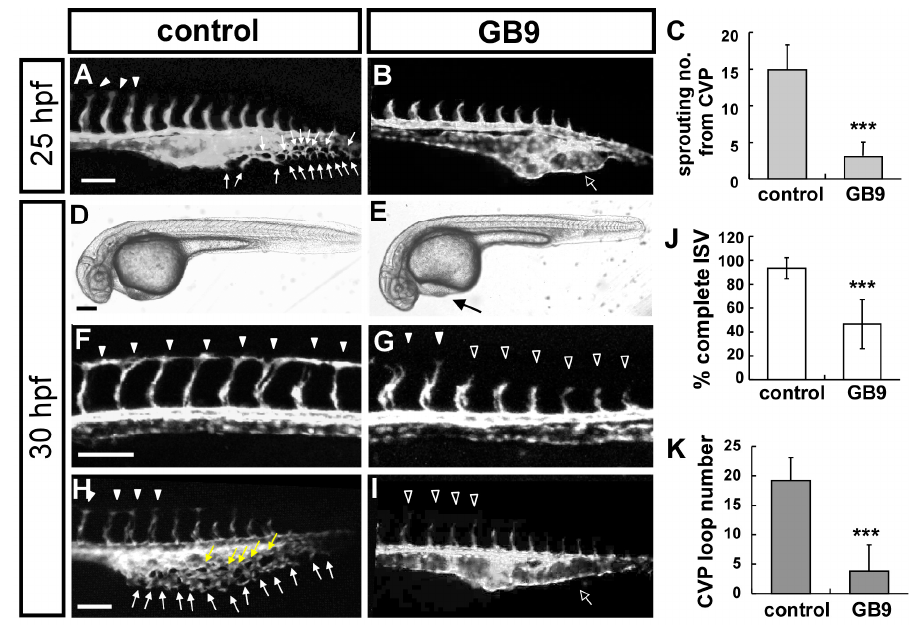
Figure 2. GB9 treatment causes vascular defects during zebrafish development. ( A , B ) Lateral view of GB9 treatment shows less ISV growth at the top of embryo and less or no angiogenic sprouting from the caudal vein plexus (CVP) ( hollow arrow in ( B )) compared to untreated controls ( arrows in ( A )) in Tg ( flk:eGFP ) that expressed GFP in endothelial cells. ( C ) Quantification of endothelial sprouting at CVP shows a five-fold decrease in GB9-treated fish ( n = 12 in control and n = 12 in GB9 sample) at 25 hpf. ( D – H ) At 30 hpf, bright field images showed GB9 treatment causes minor pericardial edema (( E ), arrow ). In untreated control embryos, ISVs reach the DLAV at the embryo’s dorsal aspect ( arrowheads in ( F , H )) and the CVP formed loop structures at the tail (( H ), arrows ). At the same stage, ISVs show slower growth at mid-somite in the GB9 treated embryos ( hollow arrowheads in ( G , I )) and less endothelial cell sprouting and loop formation at CVP ( hollow arrow in ( I )). ( J , K ) Quantification of percentage of completed ISV and CVP structures in GB9-treated fish at 30 hpf shows a ~2.2-fold and ca. six-fold reduction, respectively ( n = 12 in control and n = 15 in GB9 treated samples). *** refers to p < 0.0001 by an unpaired Student’s t -test. Scale bars are 100 µ m for ( A , B , F – I ), and 200 µ m for ( D , E ).